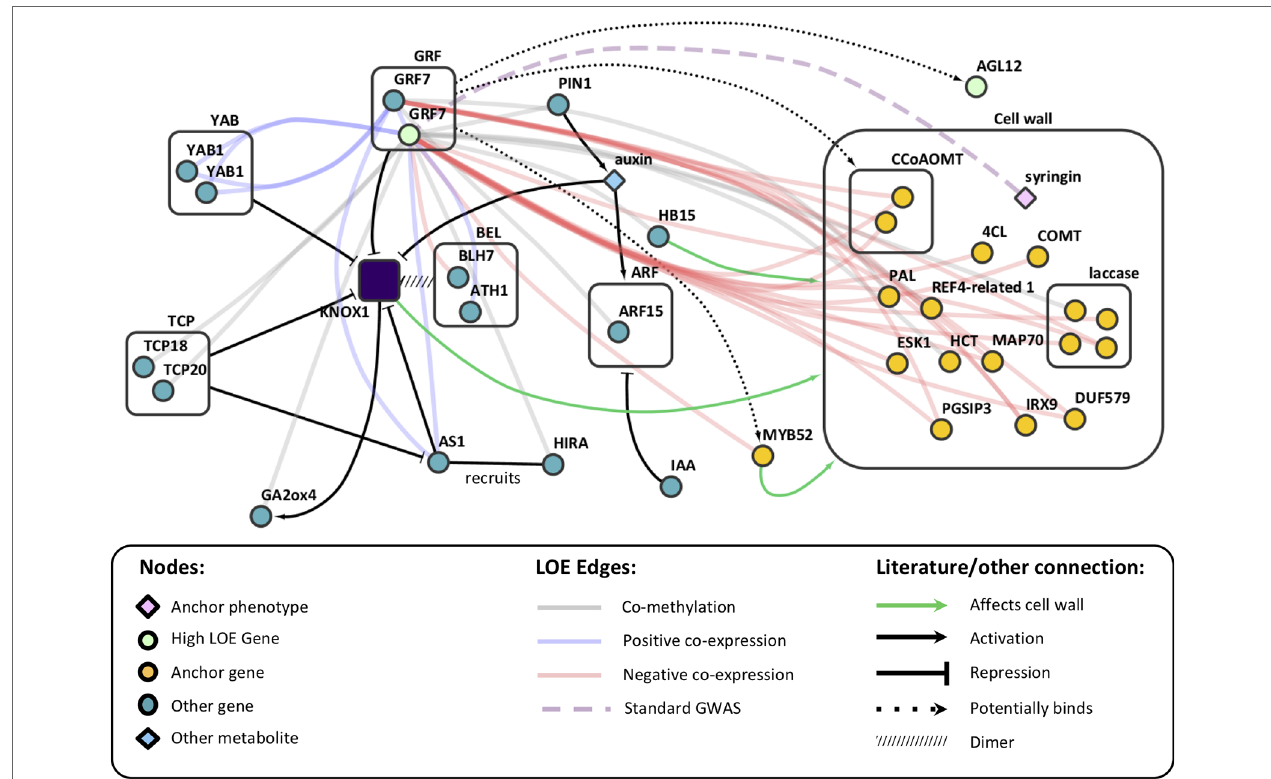
FIGURE 5 | Literature evidence linking AtGRF7 genes to AtKNOX genes and the cell wall, overlaid on LOE edges from the PtGRF9 subnetwork. See Supplementary Table S13 for P. trichocarpa